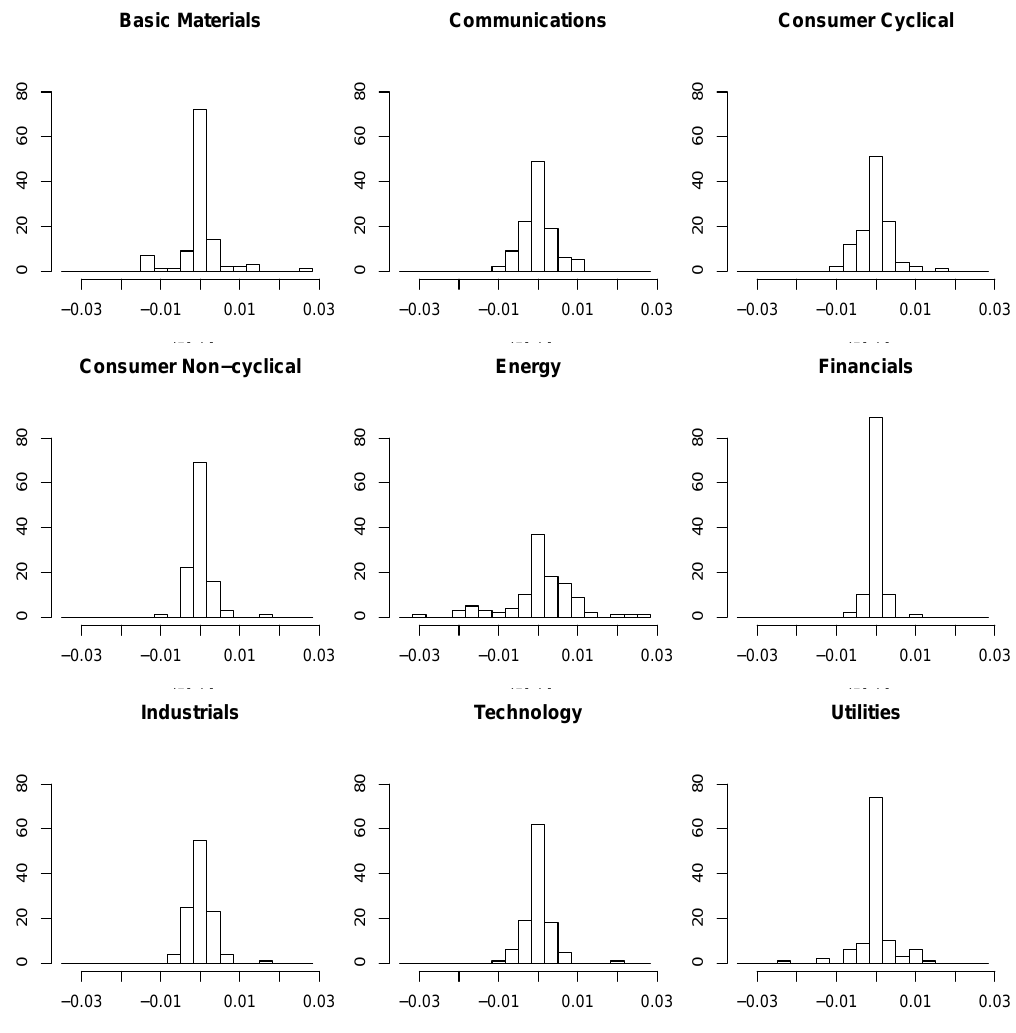
Figure 2. Histograms of monthly differences of the aggregated sector probabilities of default